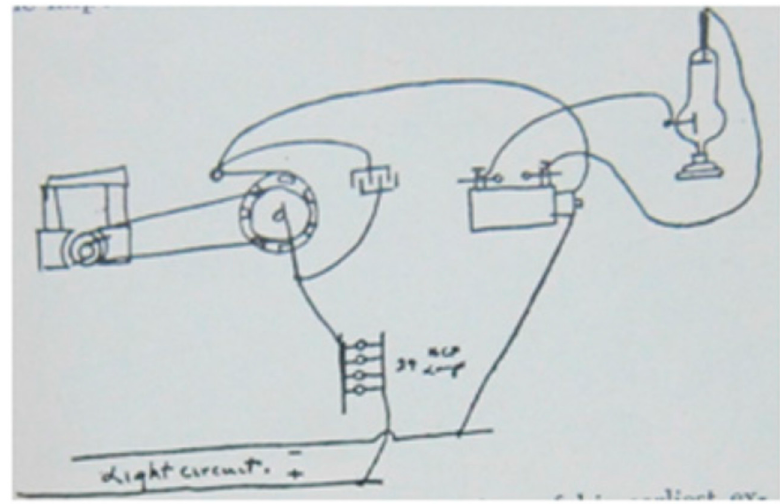
Figure 4. Sketch of Edison’s early X-ray apparatus. (Courtesy: The Trail of the Invisible Light . Ref. 1).